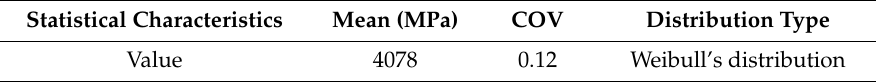
Table 1. Statistical characteristics of CFRP [33].